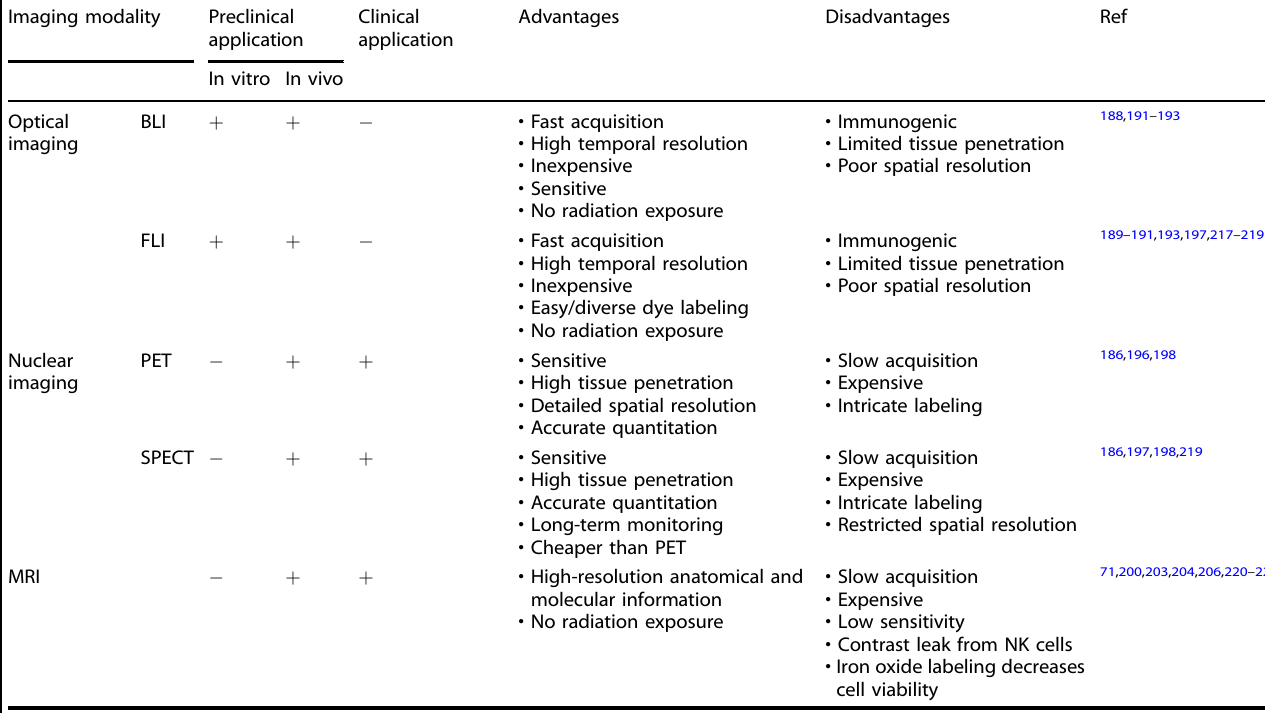
Table 5. Imaging of NK cells in brain tumor therapy. Imaging